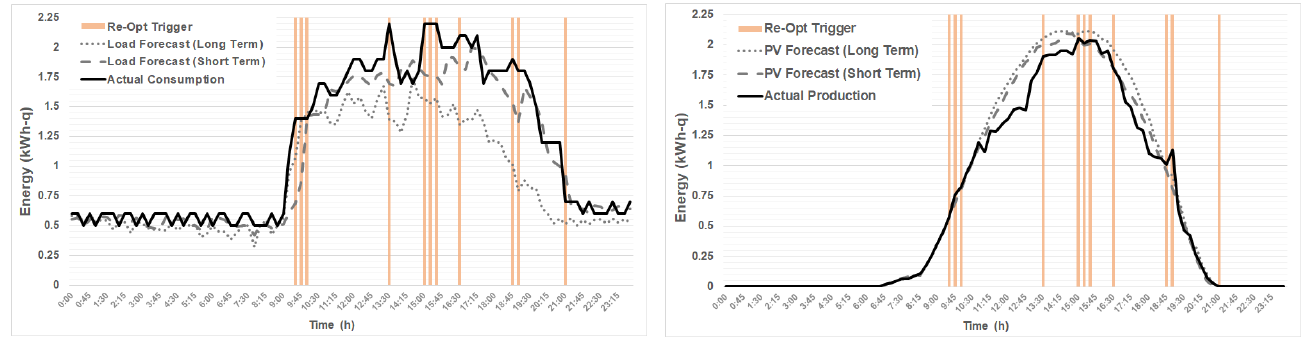
Figure 5. Scenario A—Optimisation mode on 15/7: BESS/grid operation.